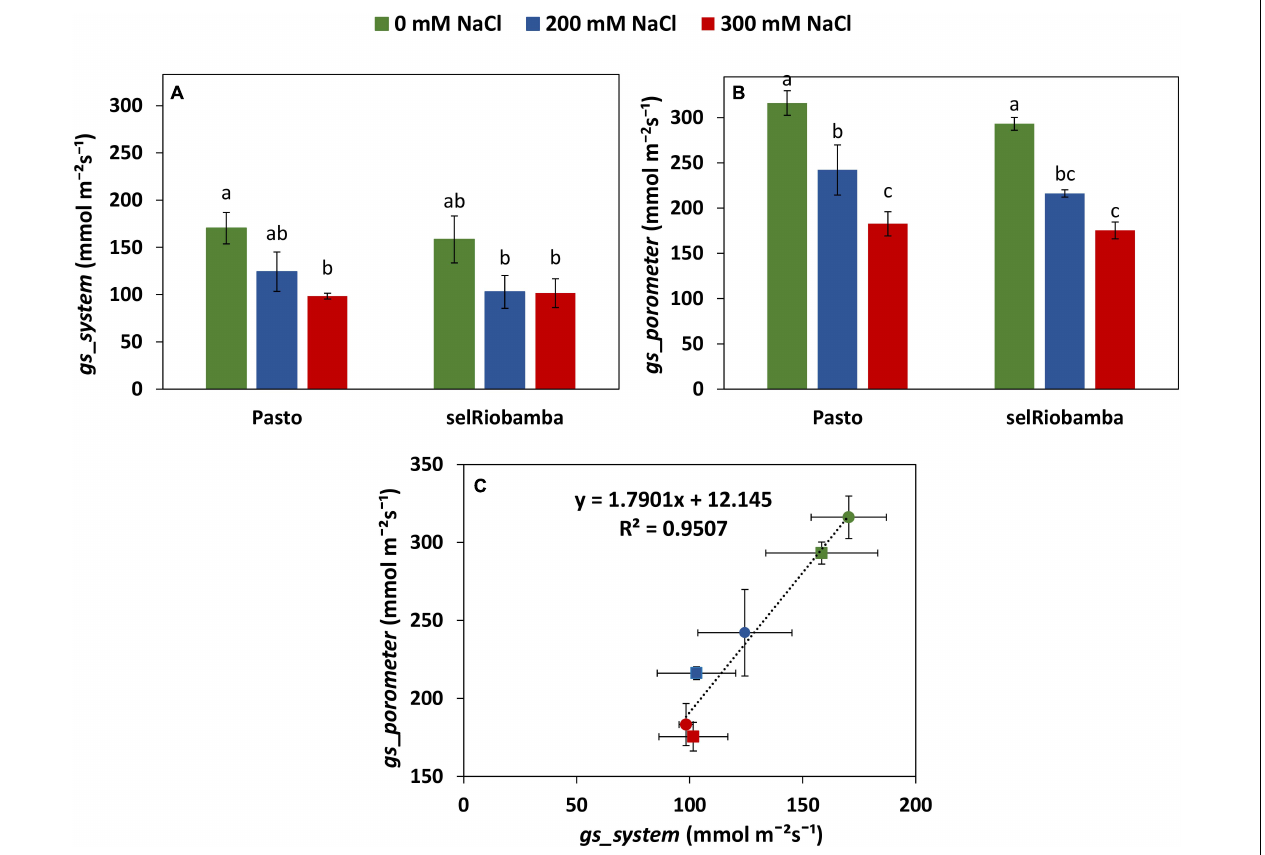
FIGURE 4 | Comparison of the derived versus porometer stomatal conductance ( gs ). (A) gs_system derived from Plantarray data as the average gs between 12:30 to 13:15 at 58 DAS. (B) gs_porometer measured with a porometer from 12:30 to 13:15 at 58 DAS. (C) Correlation between the derived from Plantarray versus porometer gs. Means of 4 plants. Error bars indicate SE of individual means. Statistically significant differences ( p ≤ 0.05) between any variety and salt treatment combination are shown with different